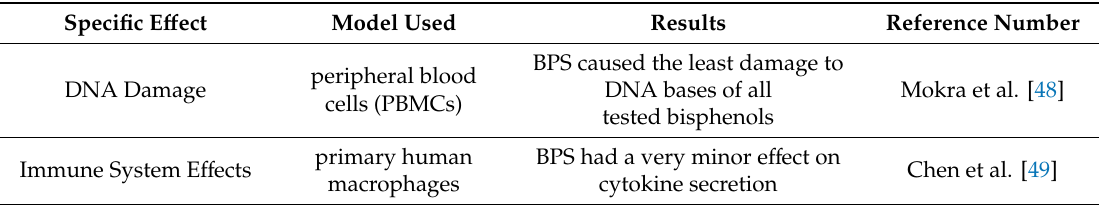
Table 5. Summary of dietary BPS exposure, DNA damage, and the immune